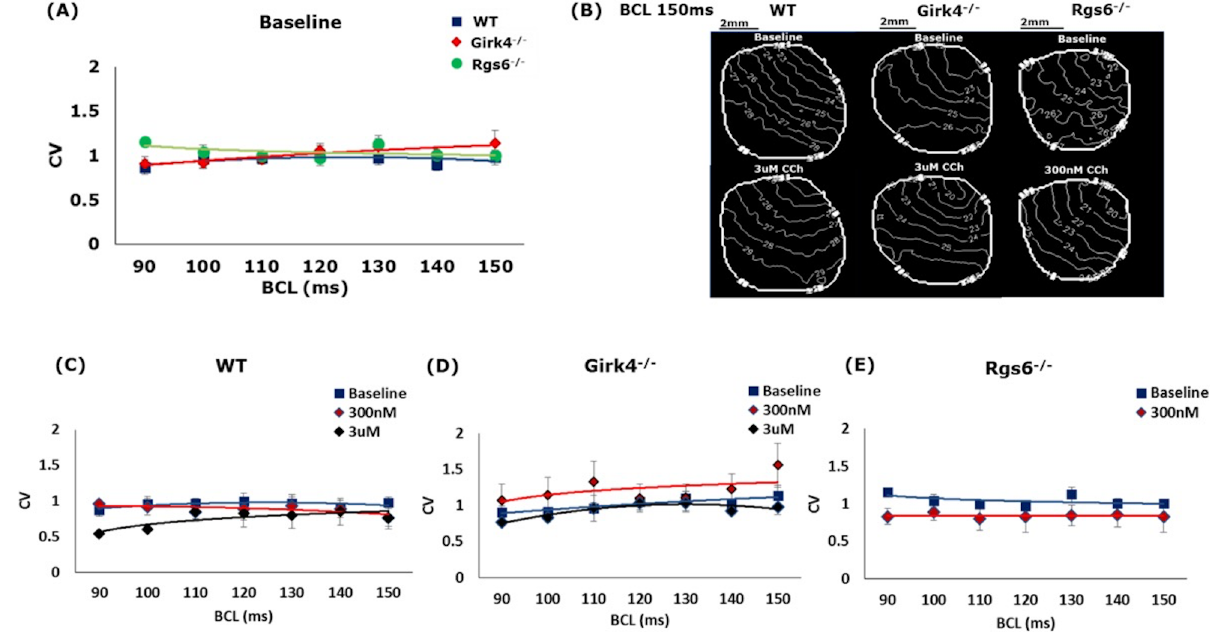
Fig 4. The effect of GIRK4 and RGS6 ablation on CV. (A) Average CV as a function of BCL in WT, Girk4 -/- , and Rgs6 -/- hearts. (B) Representative 2D activation maps from WT, Girk4 -/- , and Rgs6 -/- hearts, constructed at BCL = 150 ms both at baseline and post-CCh injection. (C-E) The effect of CCh on CV at different BCL in WT, Girk4 -/- , and Rgs6 -/- . n = 8, 5, 8 for WT, Rgs6 -/- , and Girk4 -/- , respectively. Statistics performed using 1-way ANOVA.